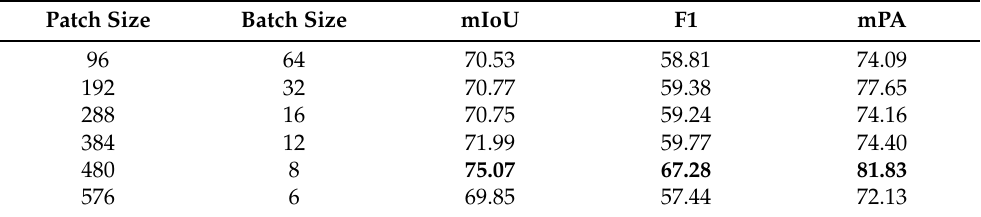
Table 5. Comparison of different models for various patch sizes on validation set. Best results are in bold.